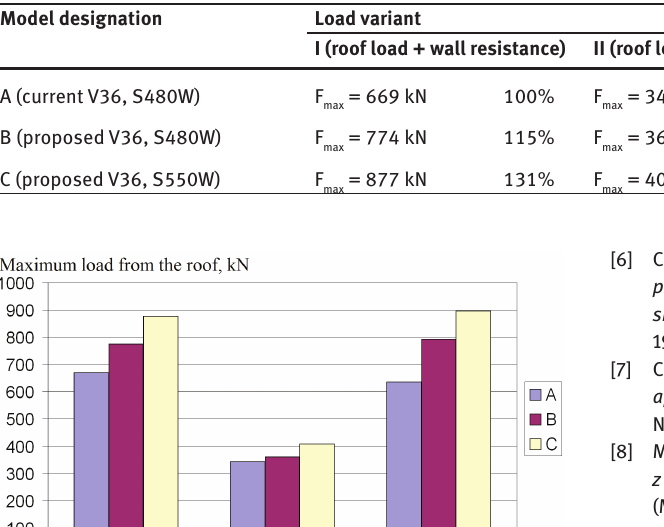
Table 6: Maximum load values transmitted by the arch support.